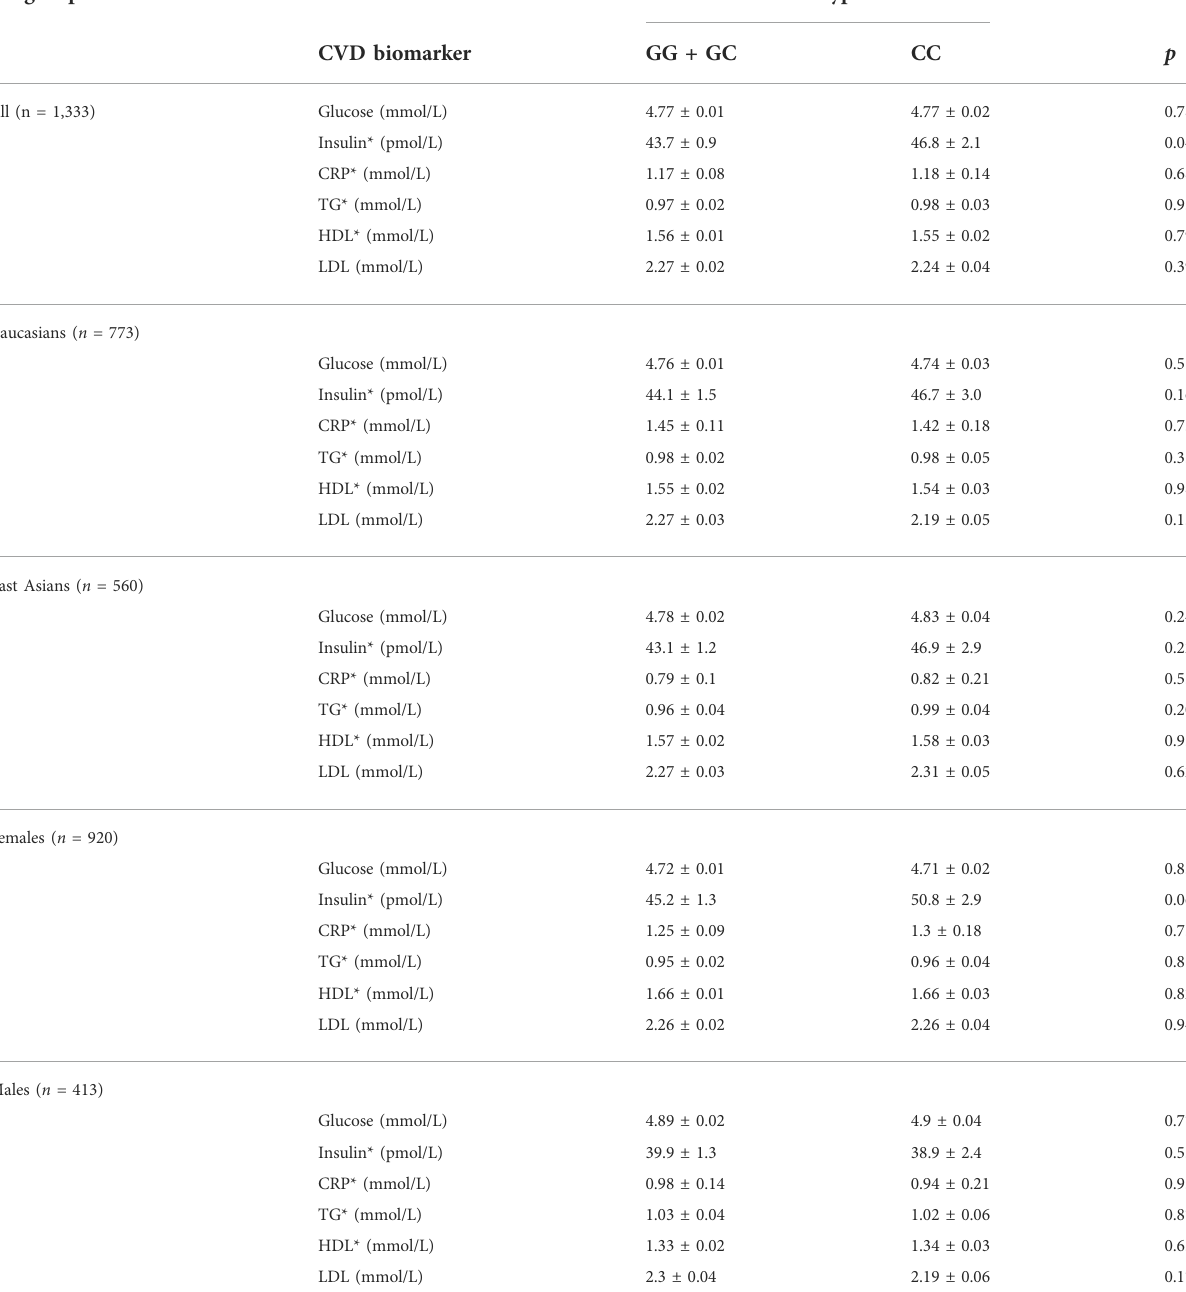
TABLE 2 Biomarkers of CVD Risk by 9p21 Genotype (rs1333049) and ethnic